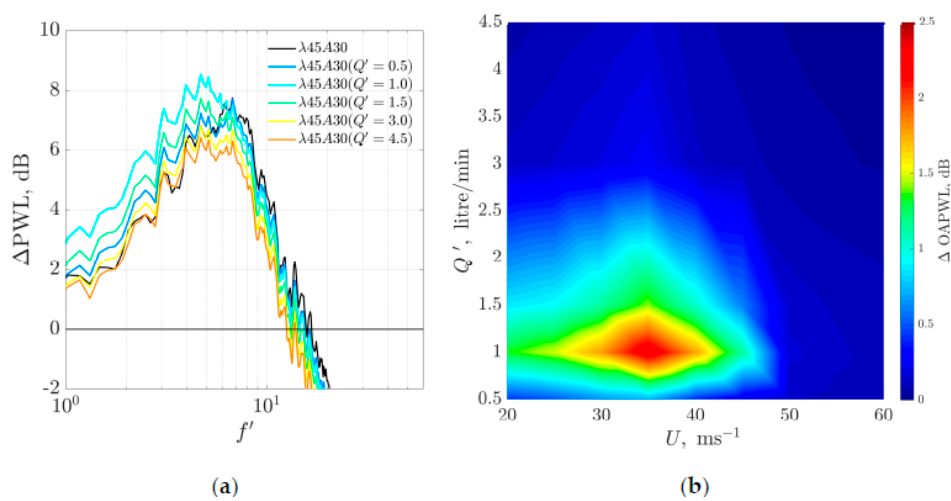
Figure 11. ( a ) Comparison of Δ PWL as a function of normalized frequency f ‘ produced by the baseline and either the serration-only ( λ 45 A 30) and hybrid leading edge device ( λ 45 A 30 + blowing Q ‘ ) at U = 40 ms − 1 and α = 0°. The leading edge blowing range covers 0.5 ≤ Q ‘ ≤ 4.50 L/min, and ( b ) contour map of Δ OAPWL produced by the difference in OAPWL between the serration-only ( λ 45 A 30) and hybrid ( λ 45 A 30 + Q ‘ ), as a function of Q ‘ and U at α = 0° .